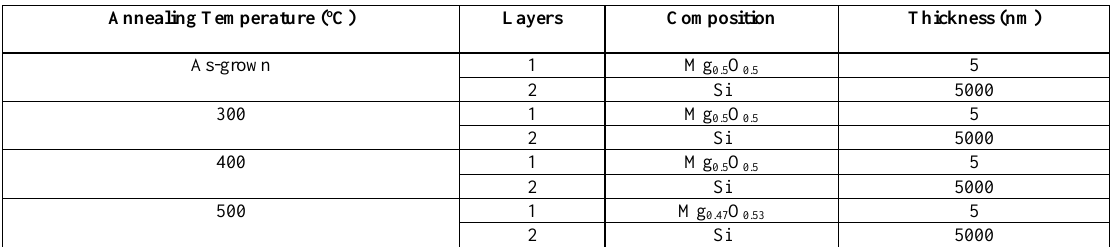
Table 1. Parameters estimated from RBS simulation of MgO film of thickness 5 nm. Layer 1 and layer 2 correspond to MgO layer and Si substrate Annealing Temperature ( o